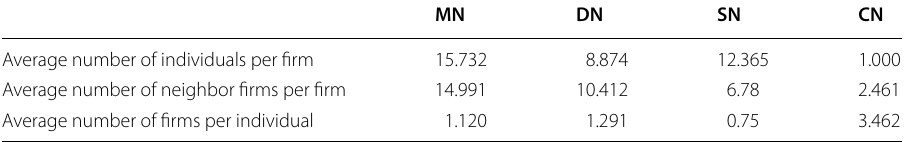
Table 14 Descriptive statistics of different interfirm networks on NEEQ SMEs dataset MN DN SN CN Average number of individuals per firm Average number of neighbor firms per firm